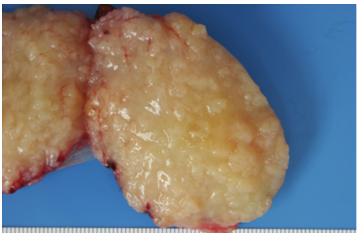
Figure 3: Gross specimen of the mass longitudinally sectioned. The capsule can be clearly seen with the pale tissue and irregular nodular cut surface.